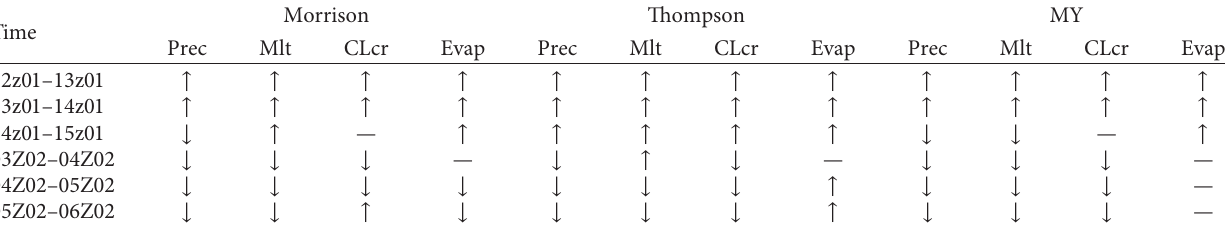
Table 3: Simulated ave-Rain, ave-Mlt, ave-CLcr, and ave-Evap trends from 1200 to 1500 UTC on 1 July and from 0300 to 0600 UTC on 2 July. Red upward arrows and blue downward arrows represent increases and decreases, respectively. “-” indicates a negligible change.